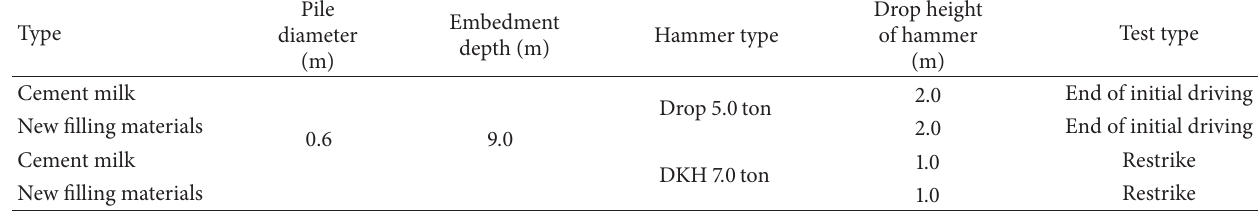
Table 3: Specifications for dynamic pile loading test.